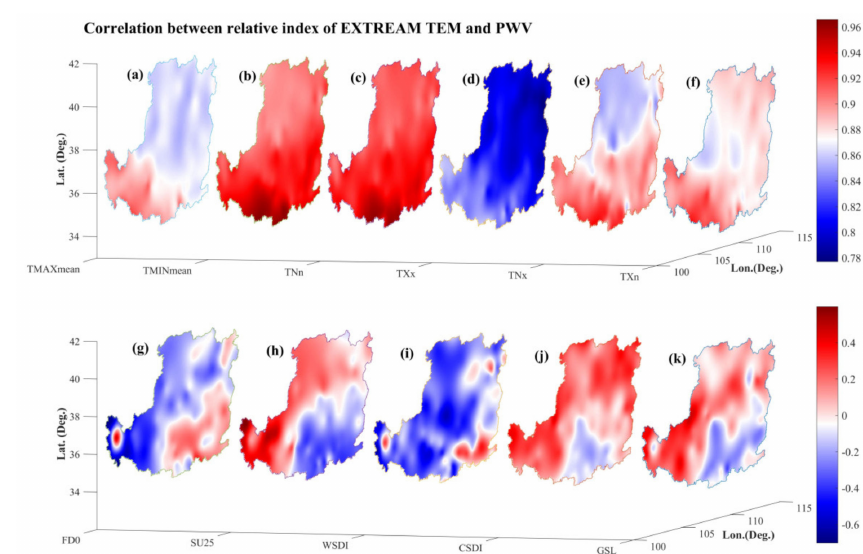
Figure 10. Pearson correlation coe ffi cients of PWV with extreme climatic indices in the Loess Plateau region, the extreme climatic indices are ( a ) TMAXmean, ( b ) TMINmean, ( C ) TNn, ( d ) TXx. ( e )TNx, ( f )